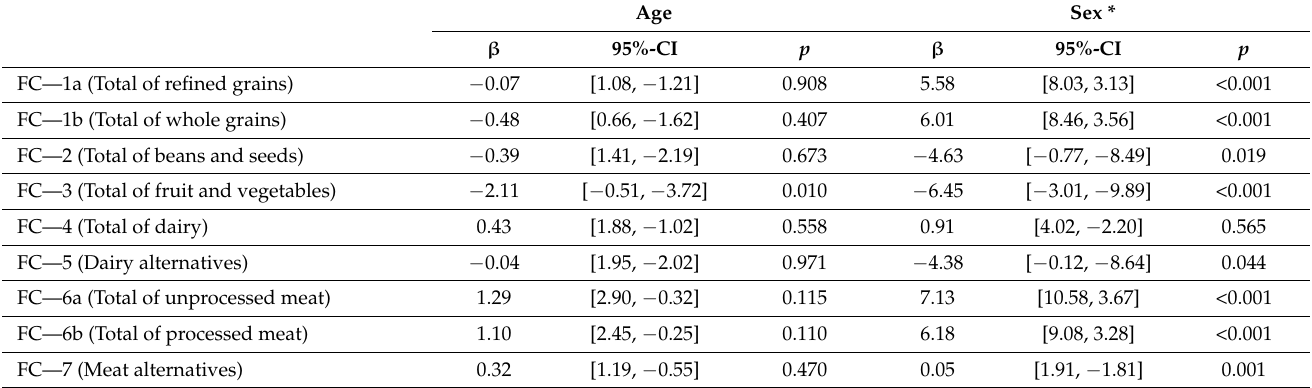
Table 4. Regression results for age- and sex-based interactions in food